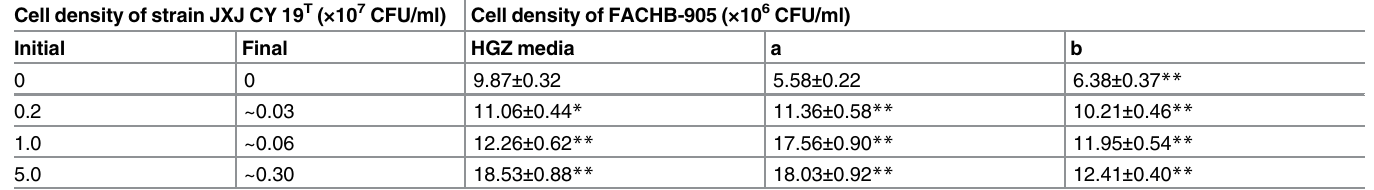
Table 3. Cell numbers (mean ± standard deviation; n = 3) of Microcystis aeruginosa FACHB-905 after co-culturing with strain JXJ CY 19 T for 60 days.